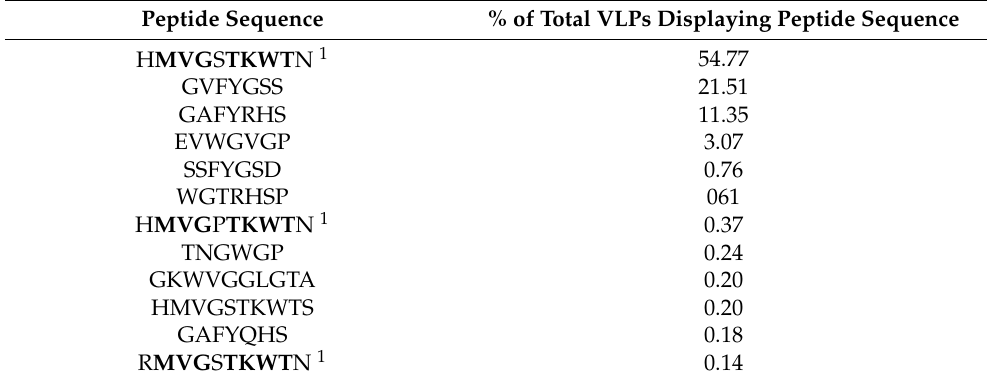
Table 1. The top 12 peptides identified by affinity selection. Peptide Sequence % of Total VLPs Displaying Peptide Sequence